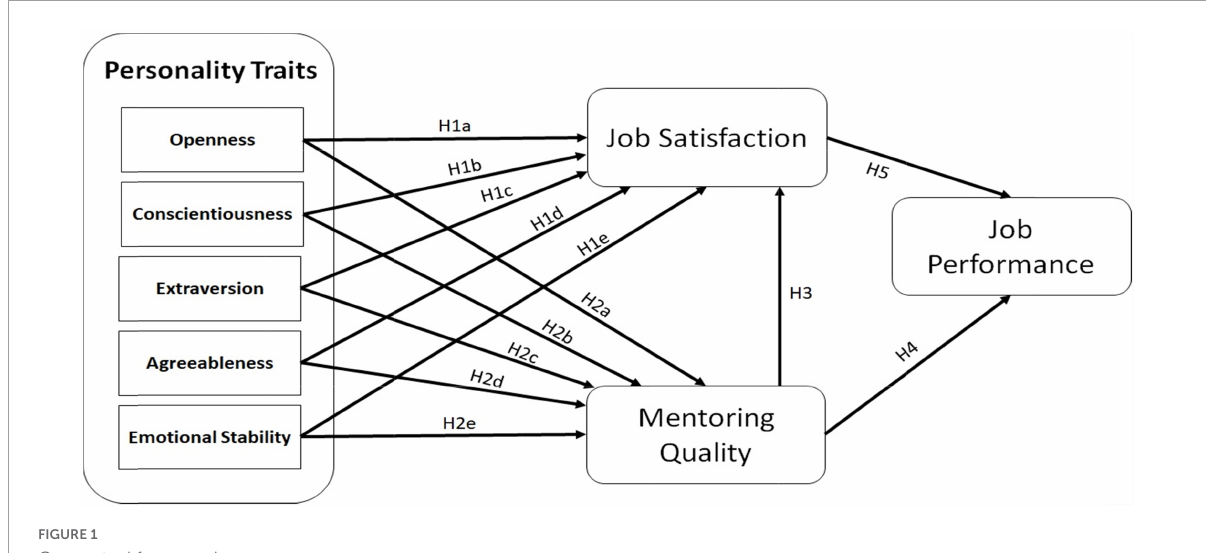
FIGURE1 Conceptual